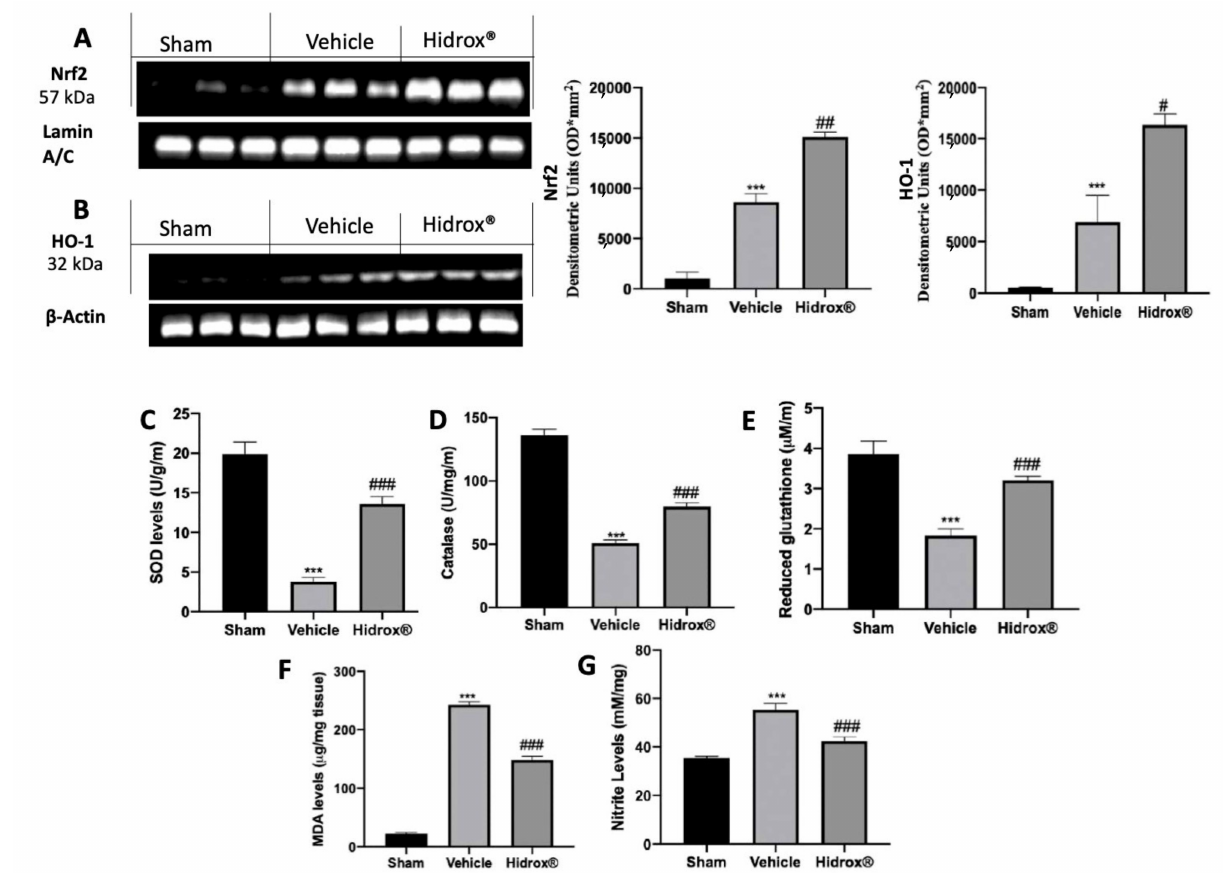
Figure 2. Hidrox ® administration reduced prooxidative alterations. Western blot analysis in whole brain of Nrf2 ( A ), HO-1 ( B ), SOD levels ( C ), Catalase levels ( D ), Reduced glutathione ( E ), Malondialdehyde (MDA) levels ( F ), Nitrite levels ( G ). For the analyses, n = 5 animals in each group were employed. Results were analyzed by one-way ANOVA followed by a Bonferroni post-hoc test for multiple comparisons. Densitometric analysis of a representative western blot analysis of Nrf2 expression ( A ): F (2,6) = 112.2, Densitometric analysis of a representative western blot analysis of HO-1 expression ( B ): F (2,6) = 24.07, SOD levels ( C ): F (2,12) = 40.68, Catalase levels ( D ): F(2,12) = 90.28, Reduced glutathione ( E ): F(2,12) = 27.57, Malondialdehyde (MDA) levels ( F ): F (2,12) = 177.8, Nitrite levels ( G ): F(2,12) = 50.31. A p -value of less than 0.05 was considered significant. # p < 0.05 vs. vehicle, ## p < 0.01 vs. vehicle, *** p < 0.001 vs. sham, ### p < 0.001 vs.